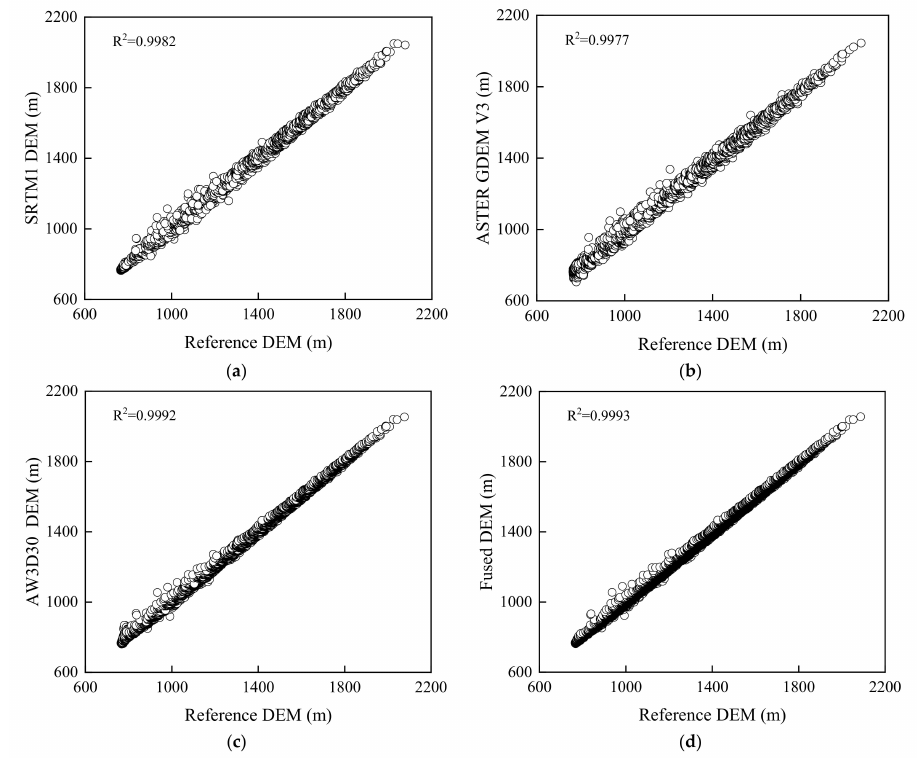
Figure 7. Correlation between SRTM1 DEM, ASTER GDEM V3, AW3D30 DEM, Fused DEM, and reference DEM. ( a ) SRTM1 DEM; ( b ) ASTER GDEM V3 DEM; ( c ) AW3D30 DEM; ( d ) Fused